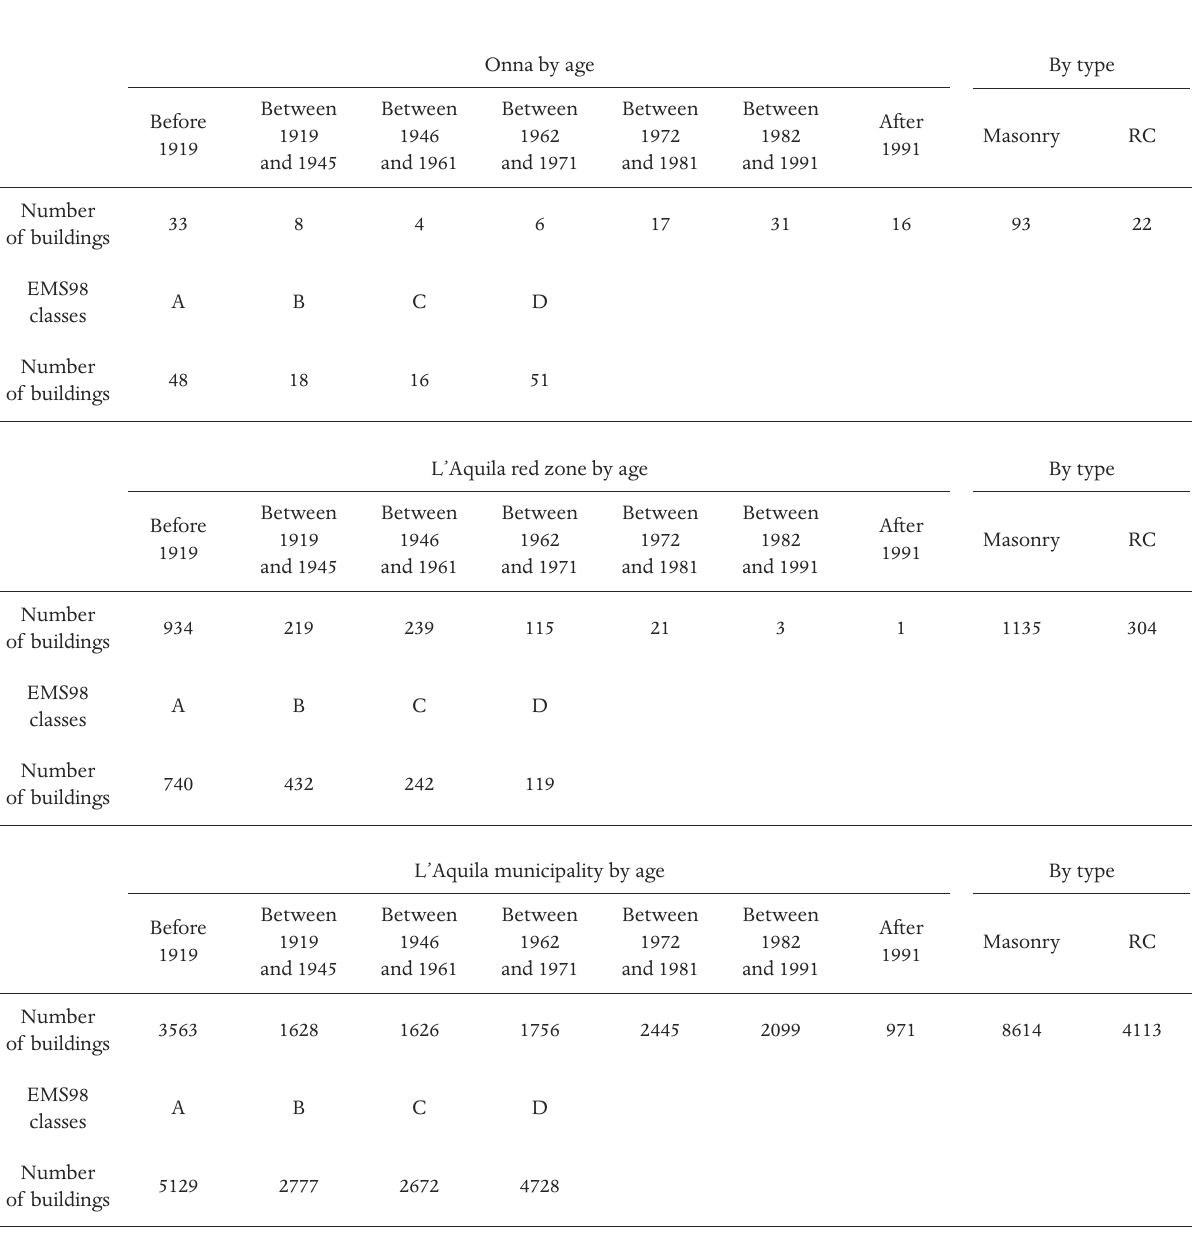
Table 5. ISTAT [2001] data for Onna, L’Aquila red zone and L’Aquila municipality and the distribution in EMS98 vulnerability classes using the approach of Zuccaro et al.